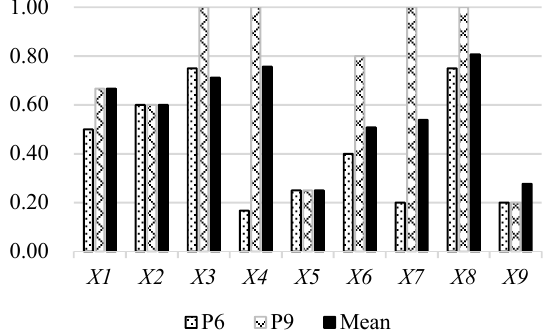
Figure 3. Comparison of policies P6 and P9.